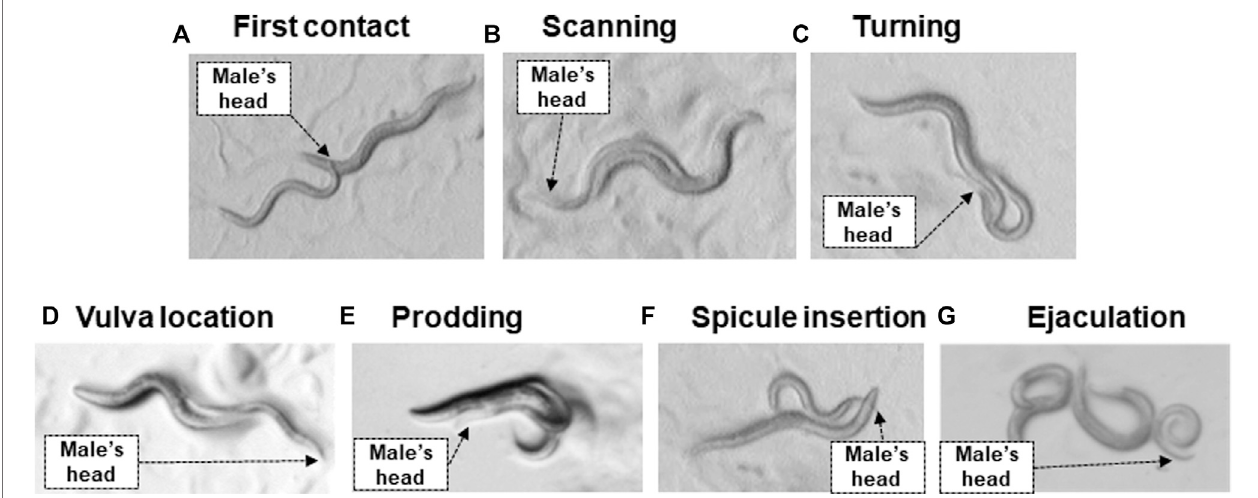
FIGURE1| Stepsinmatingbehaviorof C.elegans . (A) Firstcontact:themalecontactsthehermaphroditewithitshead. (B) Scanning:themalepressestheventral side of his tail against the hermaphrodite ’ s body then moves backwards while pressed against their body. (C) Turning: the male reaches the head or tail of the hermaphrodite and engages in turning behavior. The tail is in contact with the hermaphrodite. (D) Vulva location: the male locates the vulva and stops forward locomotion.Themale ’ stailisincontactwiththehermaphrodite ’ svulva. (E) Prodding:themalemovesforwardandbackwardsinsmallmovementsoverthevulvato locatethevulva openingprecisely.Thetailisincontactwiththehermaphrodite ’ svulva. (F) Spiculeinsertion:themaleinsertshisspiculestoopenthelipsofthevulvaand allow sperm to fl owfreelyintotheuterus.Thetailisincontact withthehermaphrodite ’ svulva. (G) Ejaculationlastsforapproximately 4 sandthespiculesremain inserted for approximately a minute, however, due to scoring, ejaculation is determined as the time point when the male loses complete contact with the hermaphrodite as it is unclear when exactly ejaculation occurs (Barr and Garcia, 2006). The black arrow shows the position of the male ’ s head.